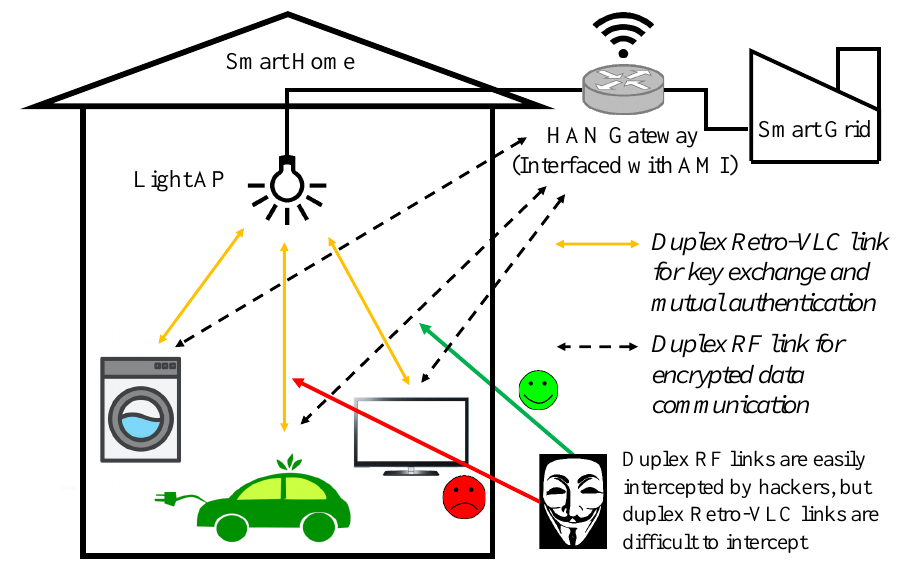
Figure 1. System architecture of heterogeneous RF and Retro-VLC home area networks.